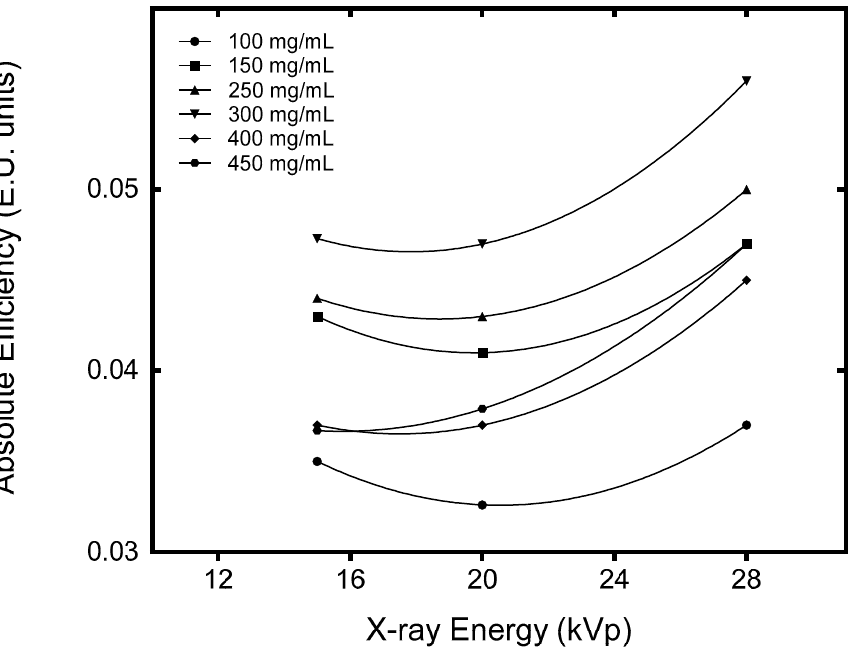
Figure 7. Predicted AE values for 100 mg / mL, 150 mg / mL, 250 mg / mL, 300 mg / mL, 400 mg / mL, and 450 mg / mL at X-ray energies of 15 keV, 20 keV, and 28 keV.